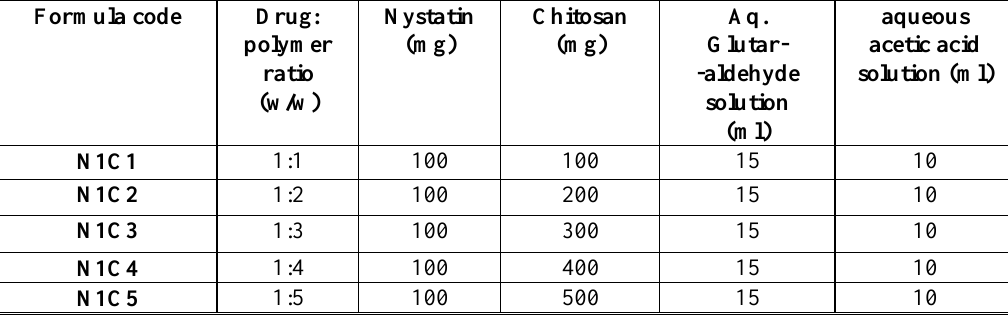
Table (1): Composition of nystatin- loaded chitosan microparticles formulas